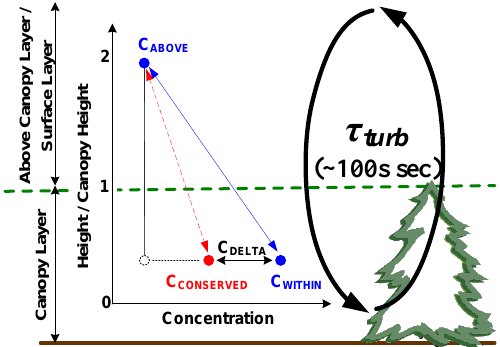
Figure 8. Schematic of our two-layered model based on the localized-near field, LNF, concept. C ABOVE represents the reference concentration, which for the above-canopy layer is defined as the measured concentration at height 18m. C WITHIN is the measured concentration within the canopy defined as the averaged concentration at 0.5, 5, and 9m. C CONSERVED is the estimated concentration based on the measured eddy-covariance flux and the eddy diffusivity calculated from sensible heat flux. C DELTA is the difference between C WITHIN and C CONSERVED and is a measure of the importance of non-conservative processes.